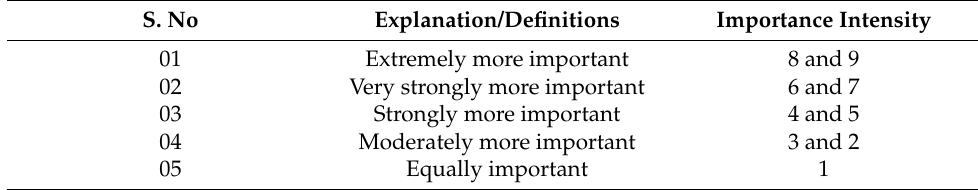
Table 2. Comparison of two factors that can induce flooding in the form of a numerical scale. S. No Explanation/Definitions Importance Intensity 01 Extremely more important 8 and 9 02 Very strongly more important 6 and 7 03 Strongly more important 4 and 5 04 Moderately more important 3 and 2 05 Equally important